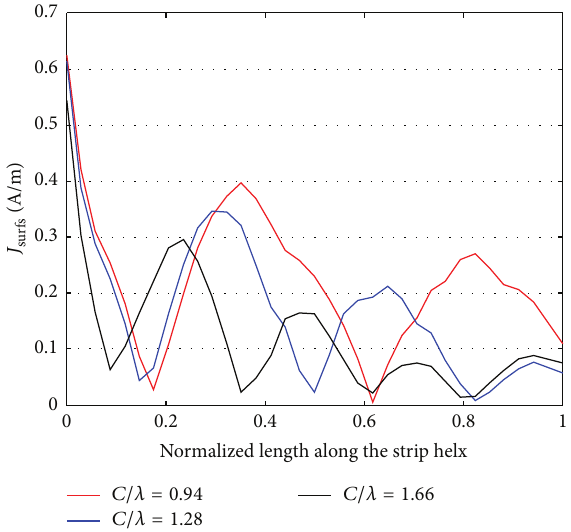
Figure 2: Current densities on the center of the strip along the helix at three 𝐶/𝜆 ratios.